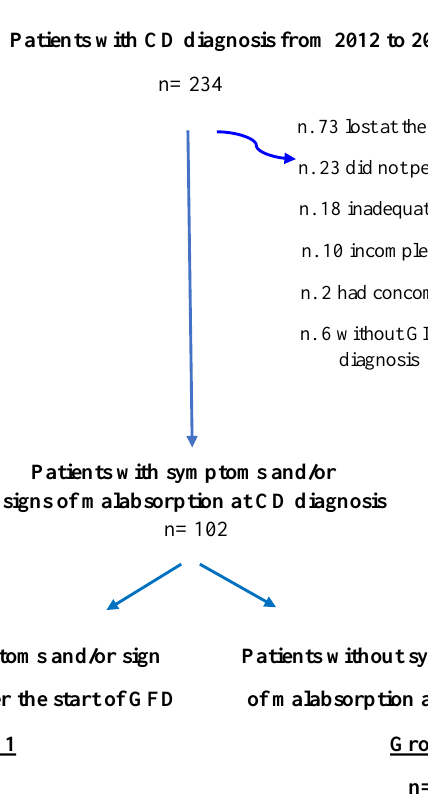
Figure 1. Flowchart of study population. CD = Celiac Disease; GI = Gastrointestinal; GFD = Gluten- free diet.